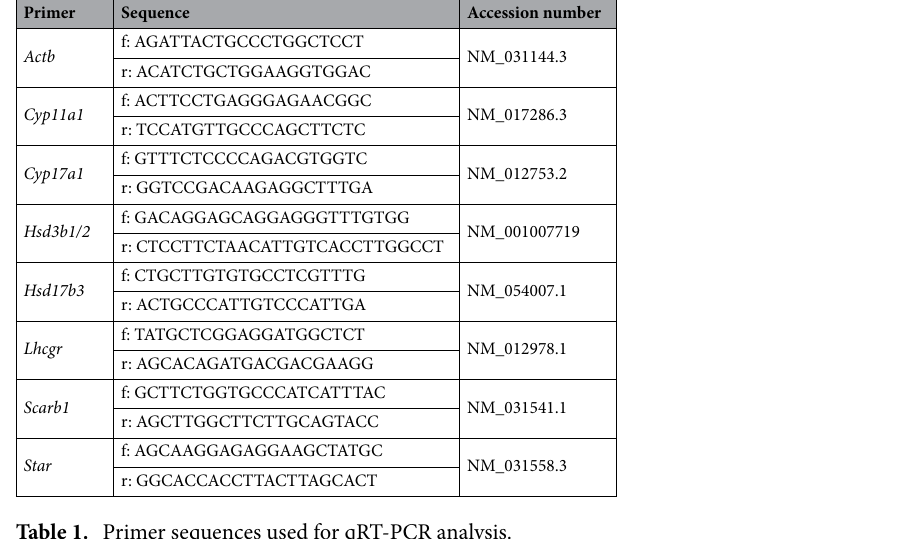
Table 1. Primer sequences used for qRT-PCR